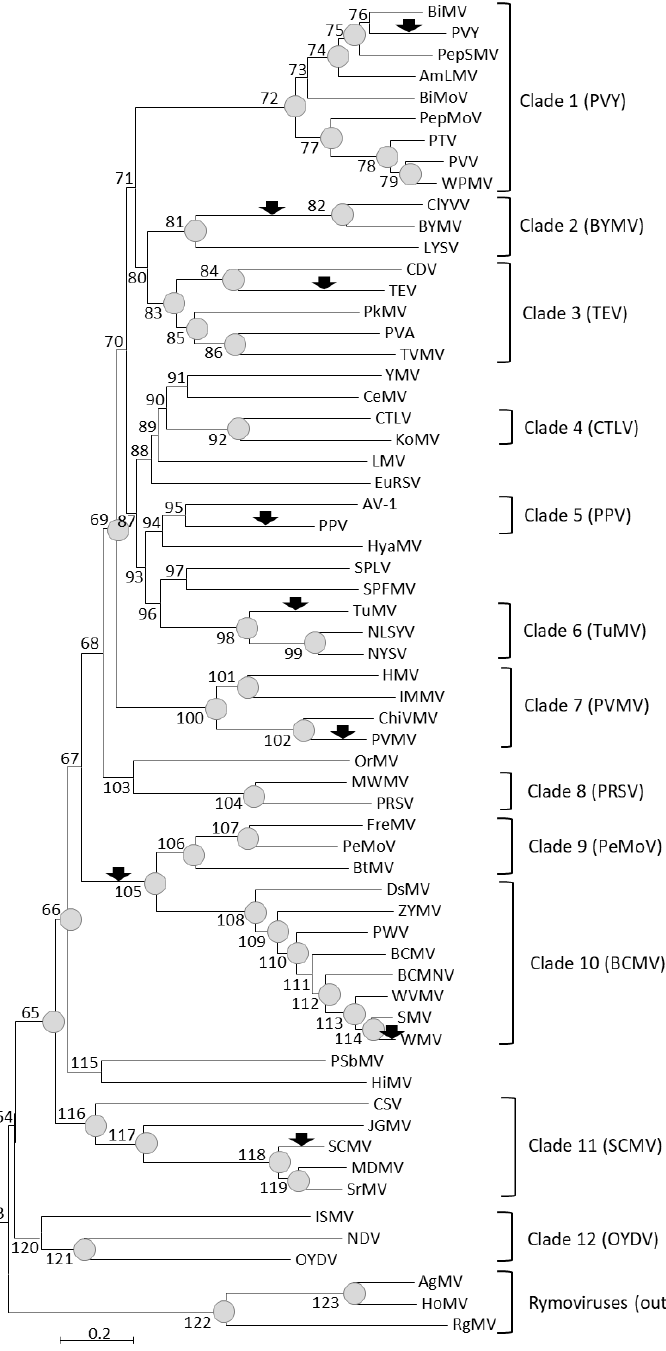
Figure 1. Phylogenetic tree of potyviruses and rymoviruses based on alignment of amino acid sequences of full-length genomes with MAFFT and the LG model with gamma-distributed rates among sites, invariant sites, and amino acid frequencies. Internal branches are numbered from 63 to 123. Terminal branches are named after the acronym of the corresponding virus species. Branches with bootstrap values above 0.7 are indicated by gray circles. Arrows indicate branches with a significantly higher number of host gains than expected by chance (Supplementary Table S3). Virus species corresponding to acronyms and GenBank accession numbers are as follows: Agropyron mosaic virus (AgMV; accession NC_005903), Amaranthus leaf mottle virus (AmLMV; MN709786), Asparagus virus 1 (AV-1;